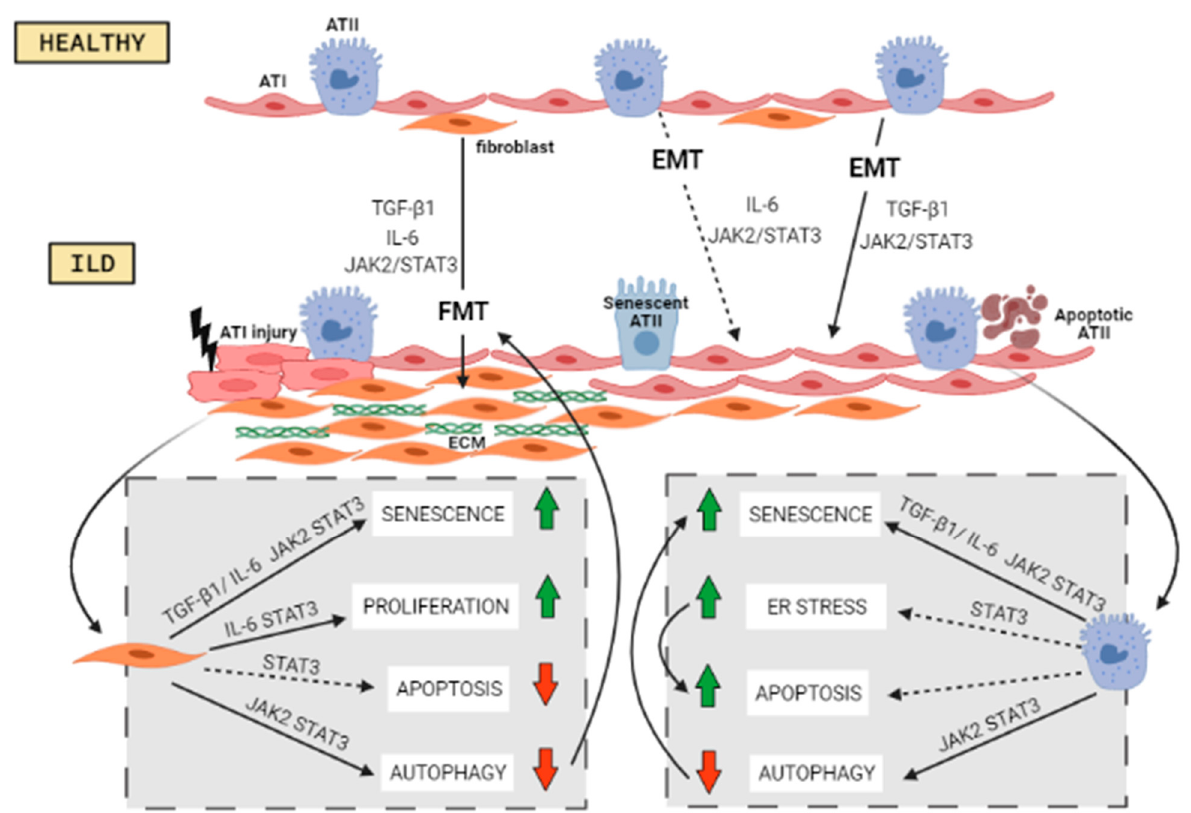
Figure 2. Cellular processes implicated in the pathogenesis of ILDs, and their relationship with JAK/STAT signaling pathway. Abbreviations: Alveolar type II cell (ATII), alveolar type I cell (ATI), epithelial to mesenchymal transition (EMT), fibroblast to mesenchymal transition (FMT), extracellular matrix (ECM). The image was created with BioRender.